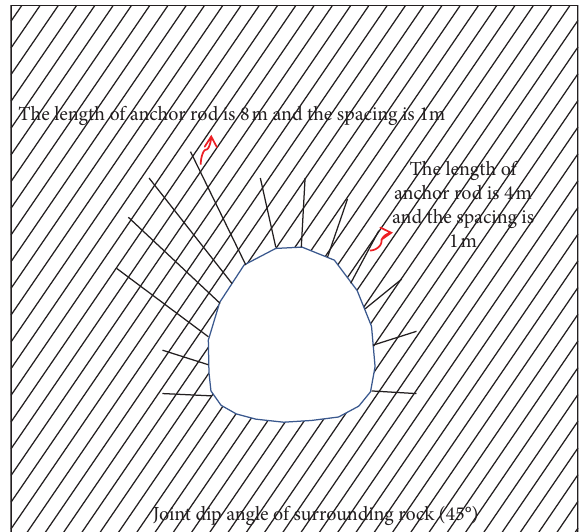
Figure 9: Support design optimization.